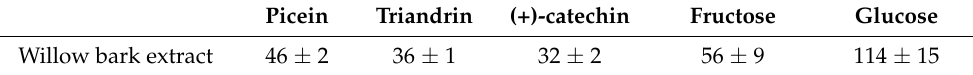
Table 2. The amounts of main components (mean ± SD) in willow bark extract presented as mg/g.